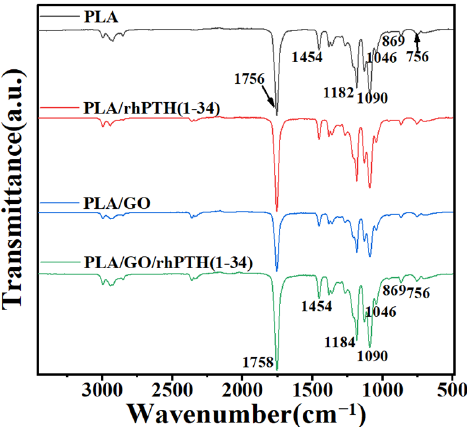
Figure 2. Fourier transform infrared (FTIR) spectra of PLA, PLA/rhPTH(1-34), PLA/GO and PLA/GO/rhPTH(1-34).